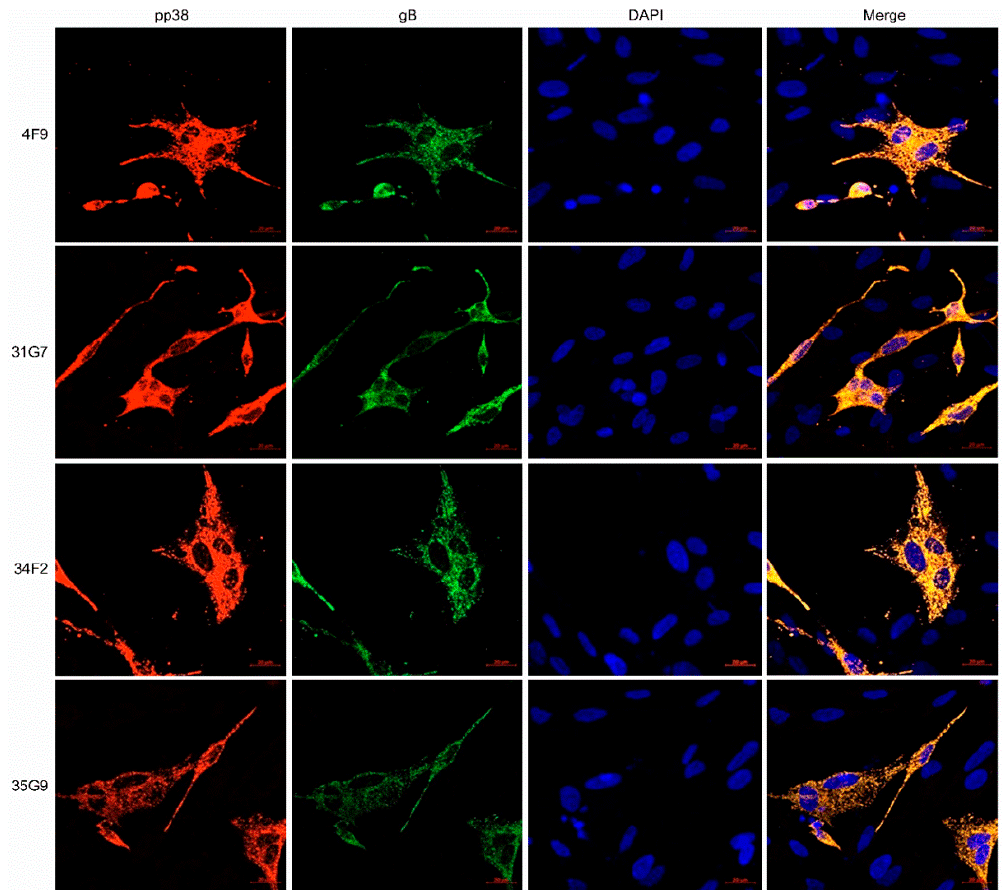
Figure 5. Confocal analysis of pp38 and gB proteins in MDV-infected CEFs. pp38, MDV-1 phosphoprotein 38 stained in red; gB, MDV-1 glycoprotein B stained in green; DAPI, 4 ′ ,6-diamidino-2-phenylindole used to indicate the nuclei of CEFs in blue; Merge, fused image in yellow. Scale bar = 20 µm.